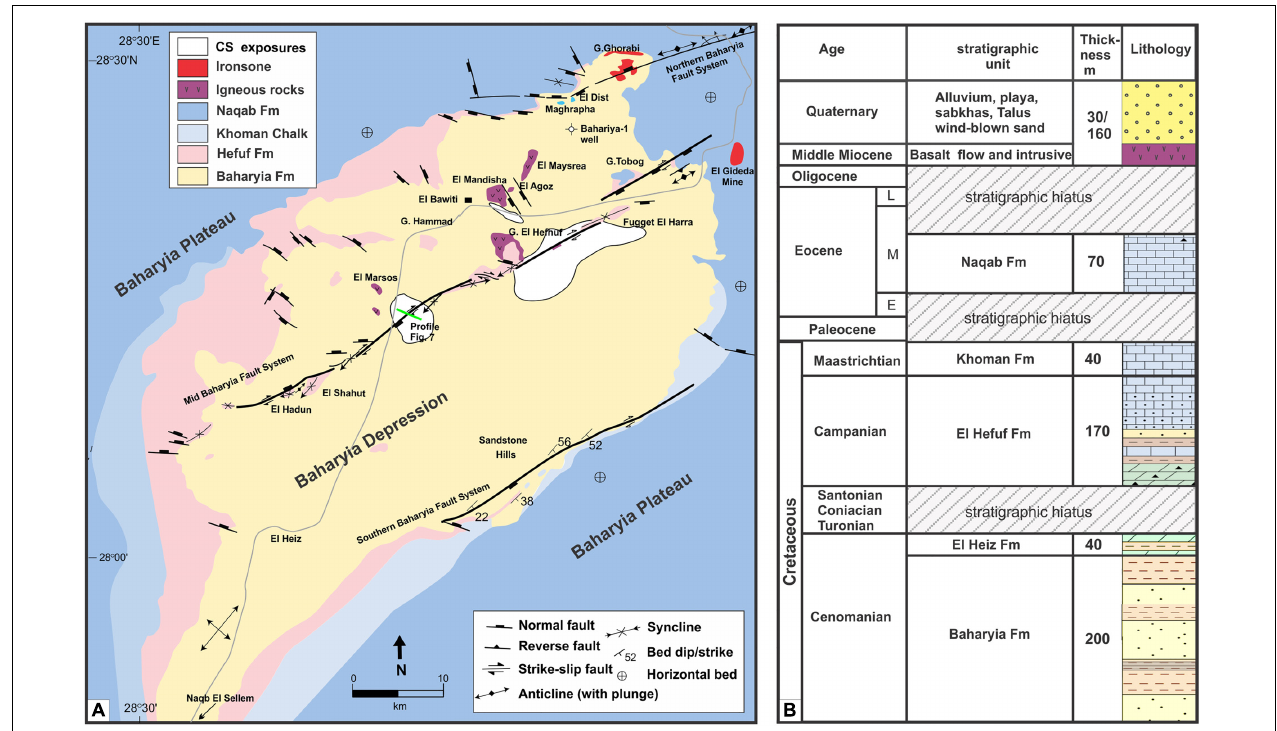
FIGURE 2 | (A) Geological map of the Bahariya Depression. (B) Generalized stratigraphic column with the main rock units, formations and stratigraphic hiatus inside and outside the Bahariya Depression.